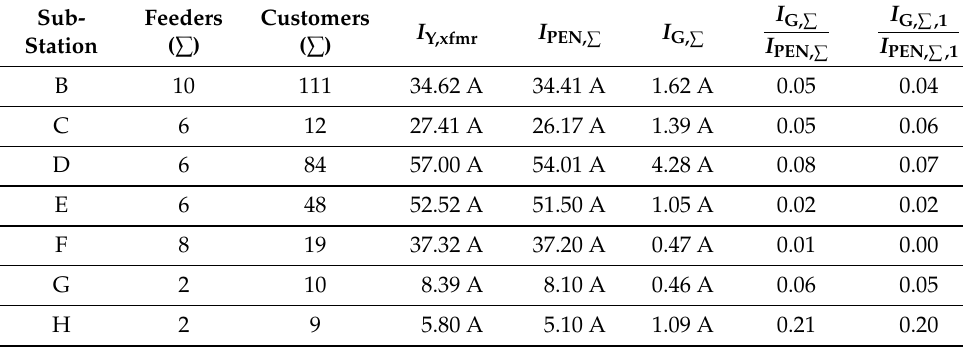
Table 3. Measurements at PEN busbars of different